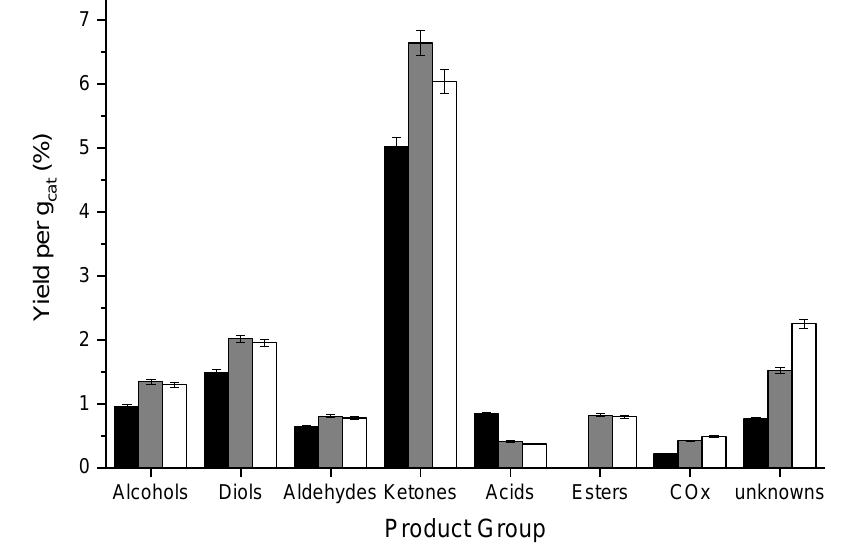
Figure 1. Influence of contact time on the yield of product groups per gram of catalyst over 0.5 g (black bar, conversion 5%), 1.5 g (grey bar, conversion 21%) and 4 g (white bar, conversion 56%) of ceria at 320 ◦ C. Respective GHSV; 10800 h − 1 , 4154 h − 1 and 1588 h − 1 .